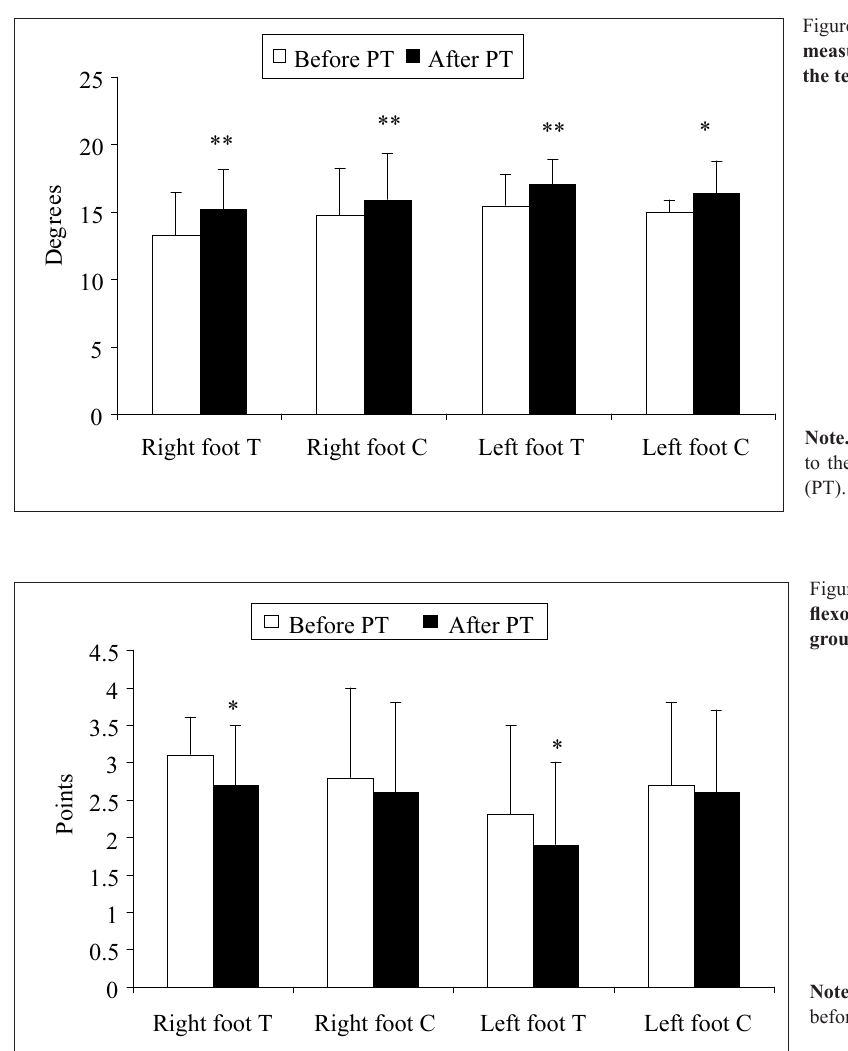
Figure 2. Changes in the spasticity of foot flexors in the control (C) and the test (T)